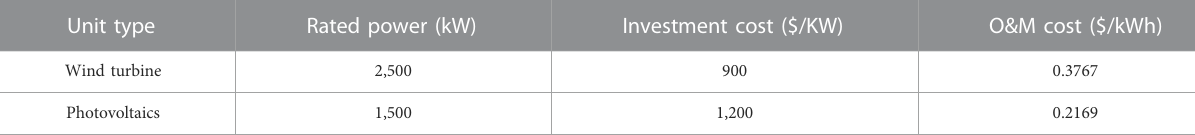
TABLE 1 Parameters of the non-dispatchable generators for the industrial microgrid (Du et al., 2020).